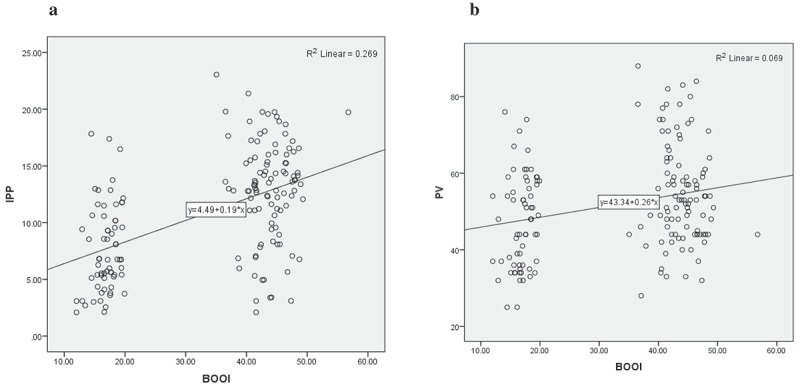
Scatter plots showing relationship between (a) BOOI and IPP (r = 0.586) and (b) between BOOI and PV (r = 0.374).